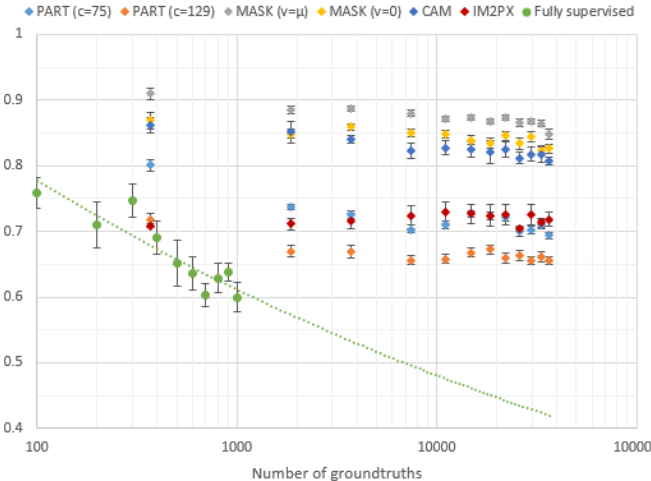
Figure 3. Evolution of the Dice index on the test set in regards with the quantity of available groundtruth. The error bars correspond to the standard deviation over ten models (random initial- ization, random selection of groundtruths). The green doted curve correspond to a modelisation following